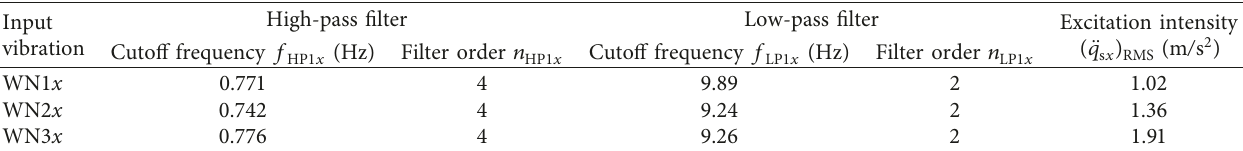
Figure 6: Power spectral densities of the simulated input vibration (solid line) at different intensities: WN1 x (a), WN2 x (b), and WN3 x (c) and their tolerances (dashed Table 1: Numerical values of the cutoff frequencies and filter orders for the input vibration at different excitation intensities: WN1 x , WN2 x , and WN3 x .